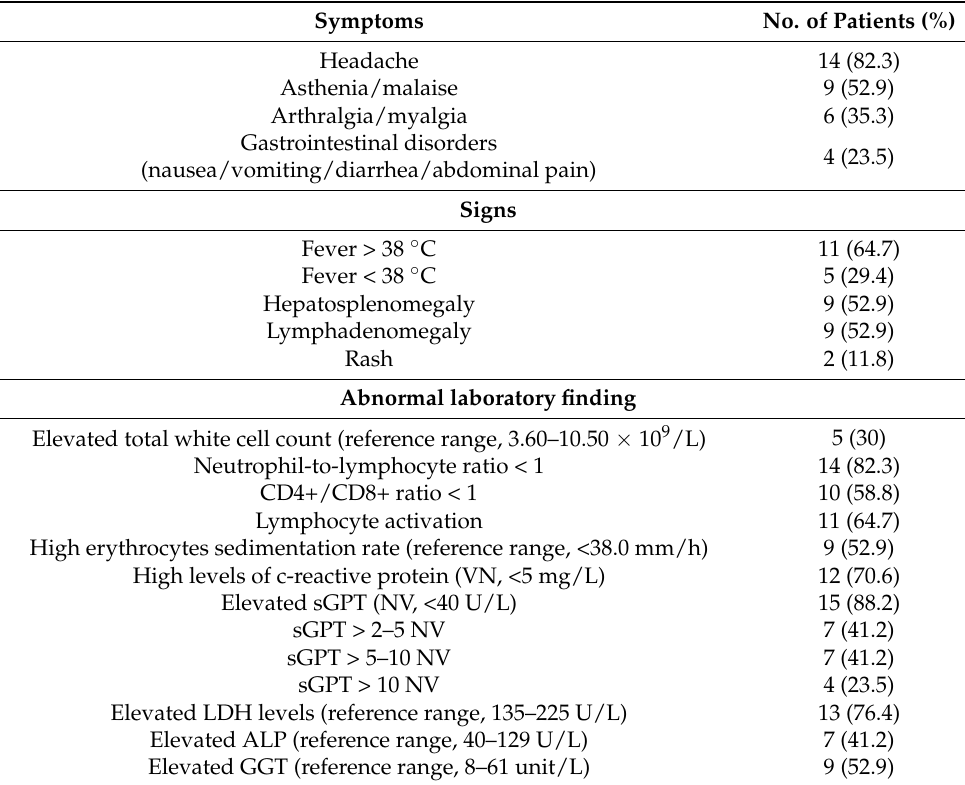
Table 1. Clinical and laboratory profile for primary CMV infection at the time of